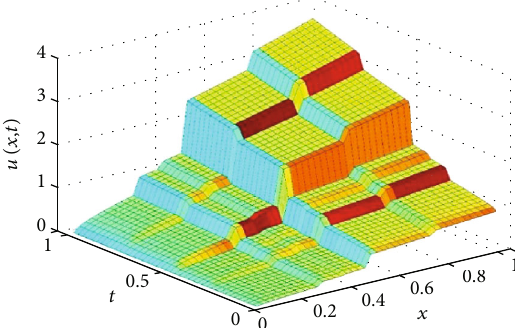
Figure 2: Variation of u ð x , t Þ versus x , t and α = ln 2/ln 3 .